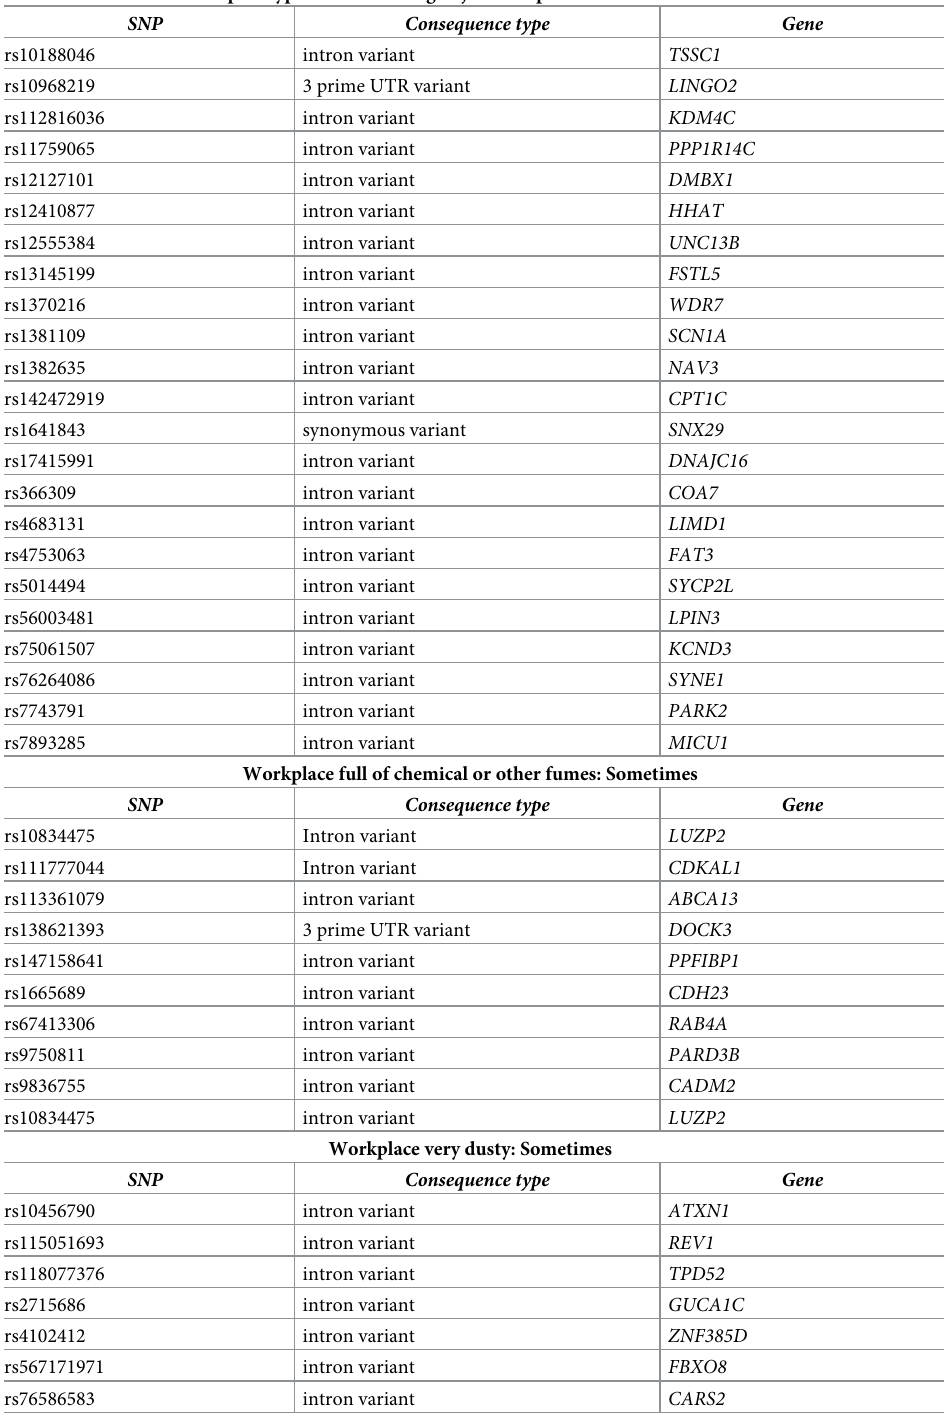
Table 2. SNP index, their types and the genes they affect, related to pollutants with the top 3 most statistically sig- nificant causal relationships. Transport type for commuting to job workplace: Car or motor